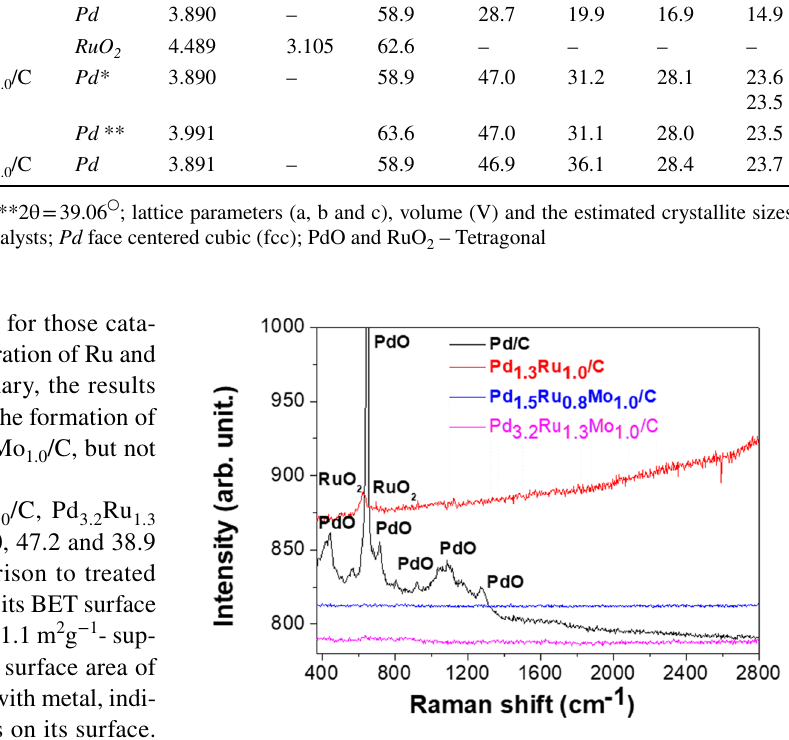
Fig. 3 Raman spectra for catalysts at 20 ○ C, excited by a 532-nm laser and 20 X